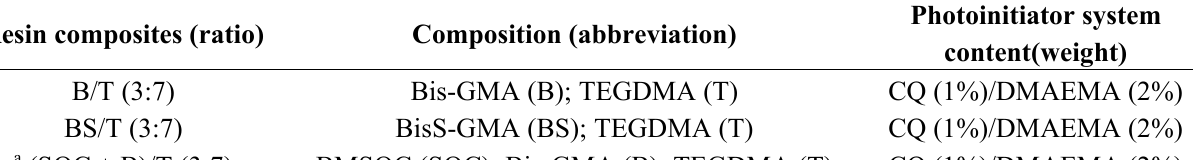
Table 2. Materials used in this